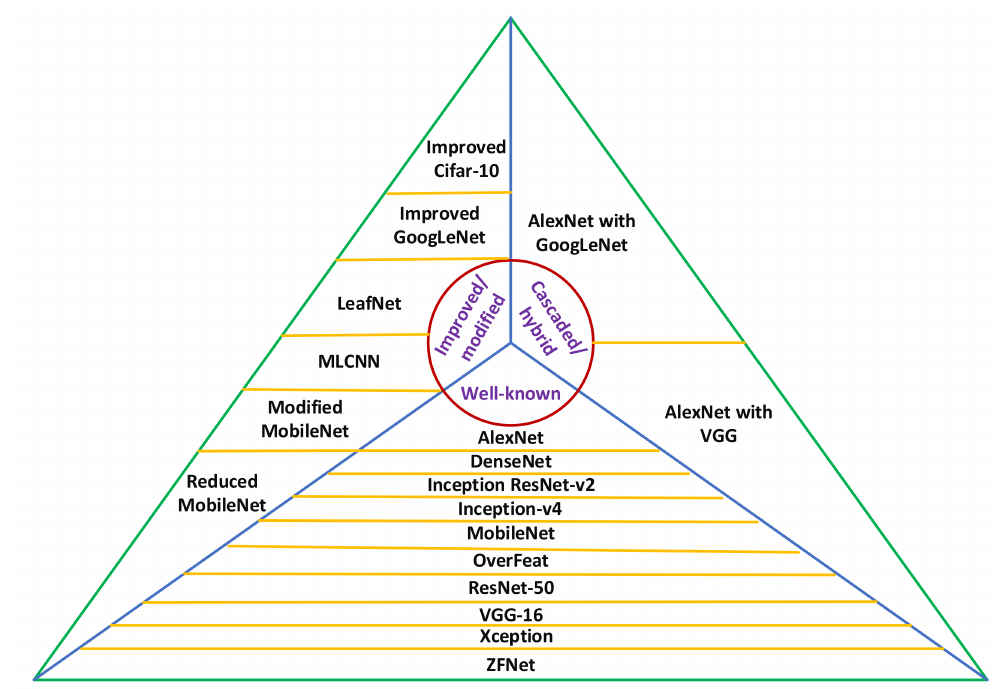
Figure 1. ThreecategoriesofDLarchitectures: well-known,improved / modified,andcascaded / hybridversions. MLCNN: Multi-label Convolutional Neural Network, VGG: Visual Geometry